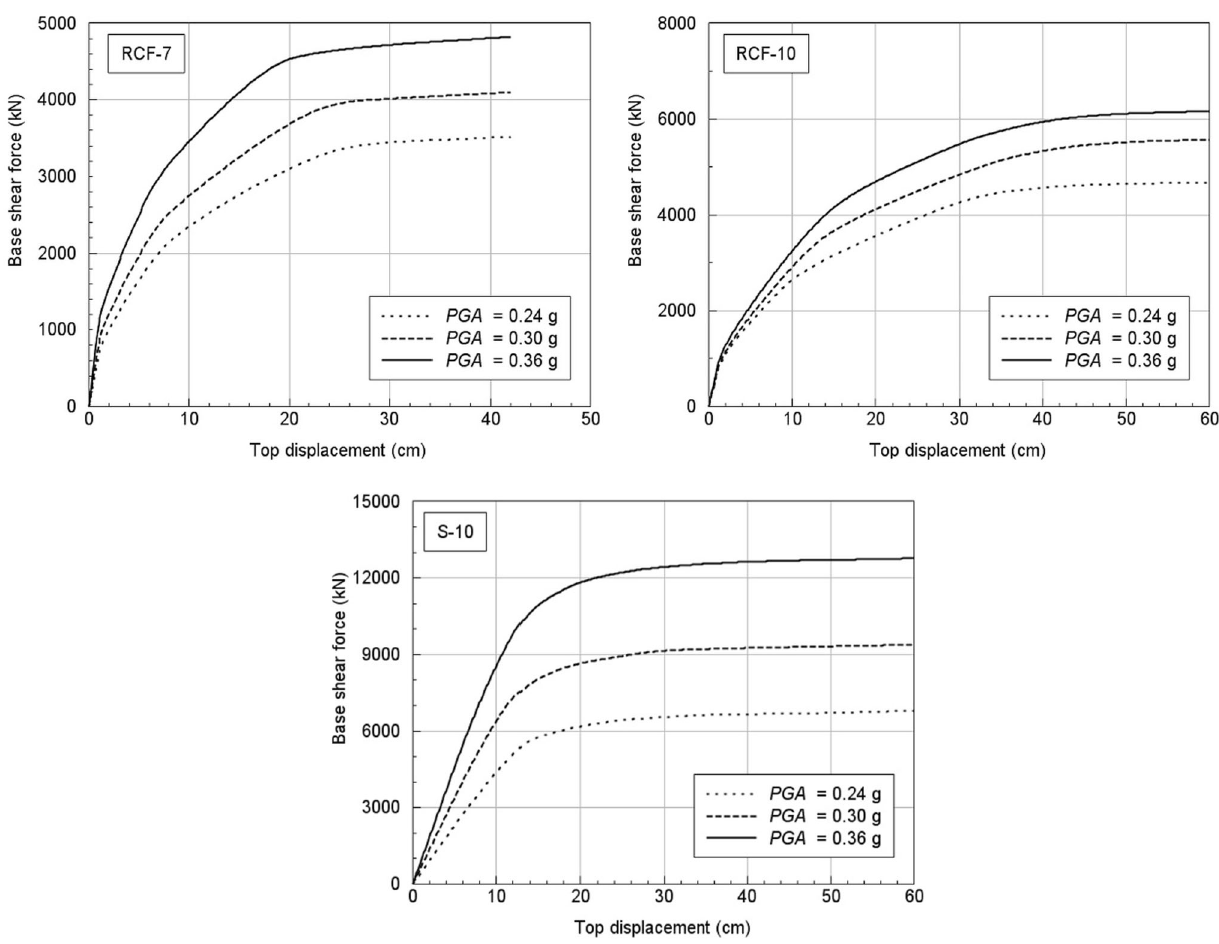
Fig. 4 Examples of pushover curves for the 7-story and 9-story reinforced concrete (RC) frame structures (RCF-7 and RCF-9), as well as for the 10-story steel structures (S-10) in Bucharest, Romania. PGA peak ground